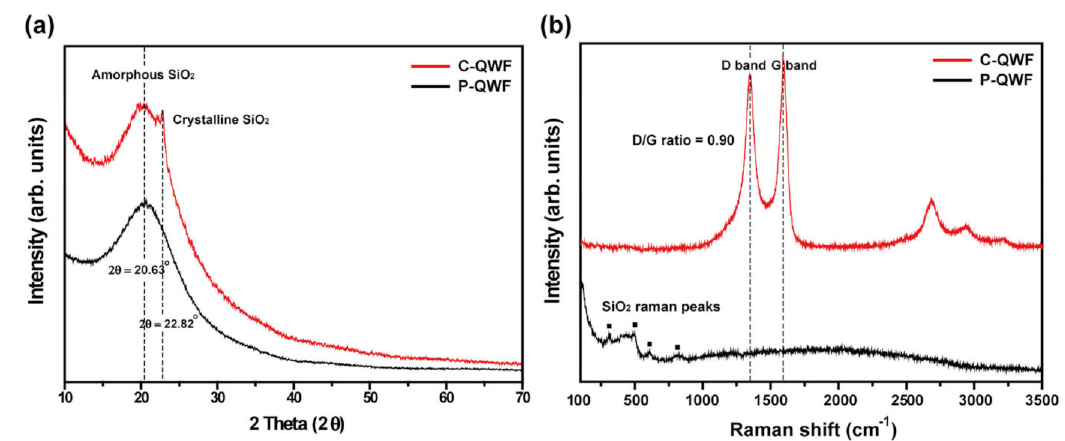
Figure 1. ( a ) X-ray powder di ff raction patterns (10–70 ◦ ) of the quartz woven fabric (QWF) electrodes; ( b ) Raman spectroscopy of the QWF electrodes.